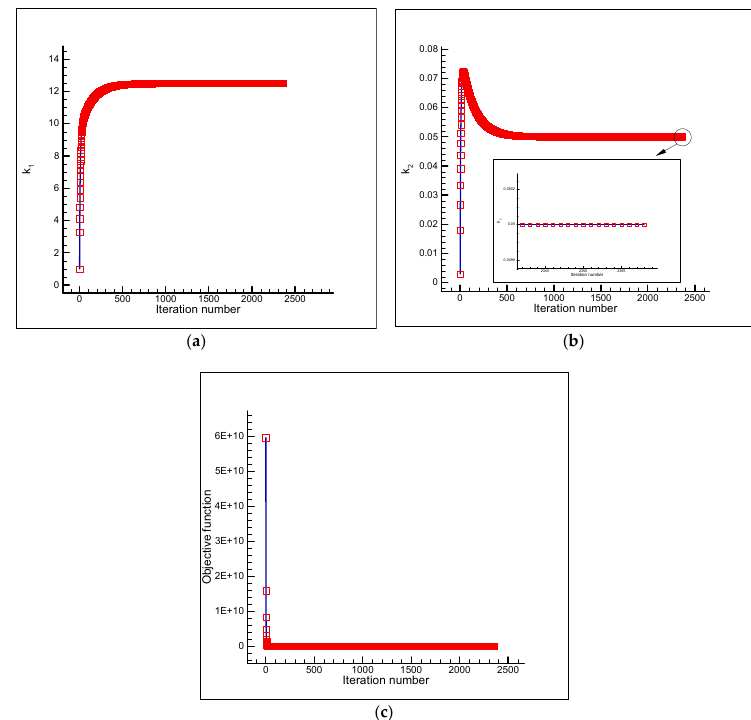
Figure 15. Estimation of k 1 ( a ) and k 2 ( b ), and the objective function versus iteration number ( c ) using the initial guess initial 2 = 1.0 + 0.003 T ( W ) and a single sensor placed at the node ( i , j ) = ( 18,8 ) . k m. ◦ C